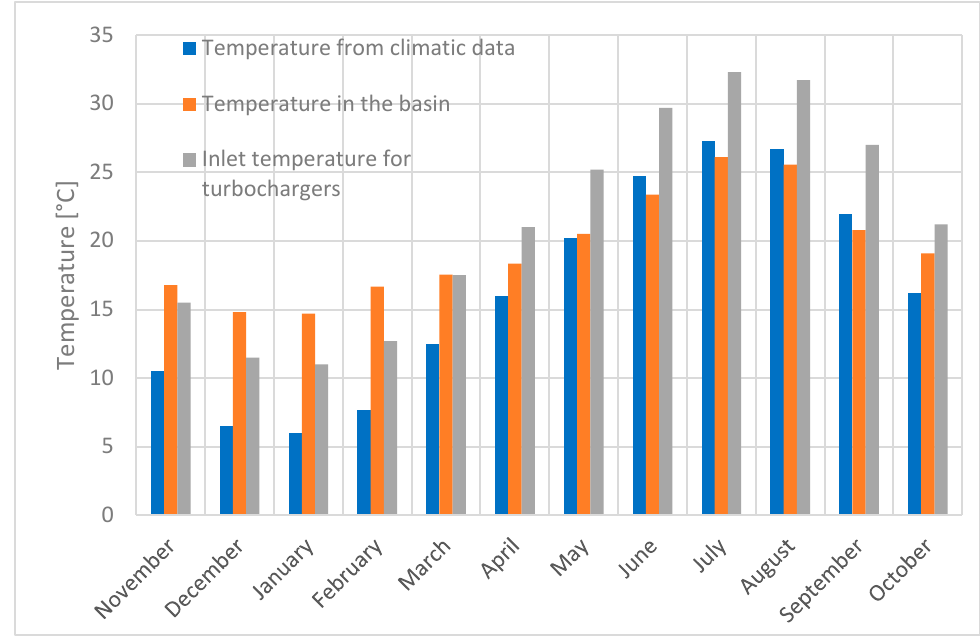
Figure 2. The temperatures used for the calculations from different months of the year, including temperatures from climatic data, temperatures in the basin, and ilet temperatures at turbochargers. The site altitude for the WWTP was assumed equal to 304 m.